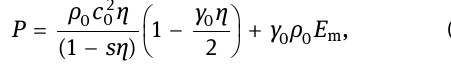
and s are the parameters of the material shock where c 0 adiabatic line, η of state parameters for the liner and shield plate materials.